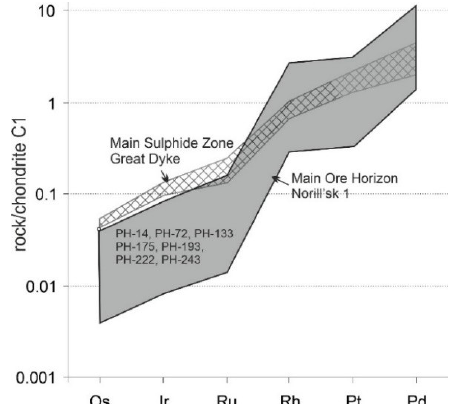
Figure 10. PGE content in the Main Ore Horizon, normalized to chondrite C1 [37], compared with the Great Dyke [38].